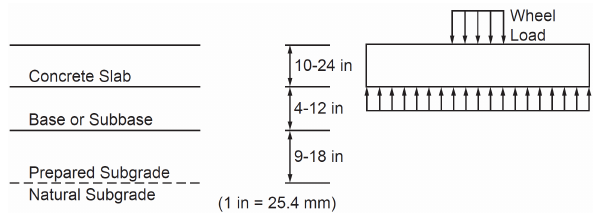
Figure 10: Cross section and stress distribution in a rigid pavement (from